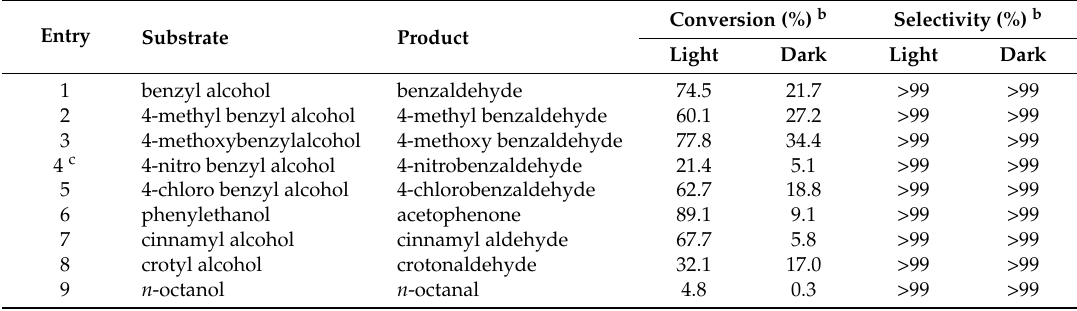
Table 4. Oxidation of different alcohols over 3 wt. % Au/Ni 3 Al HT a .